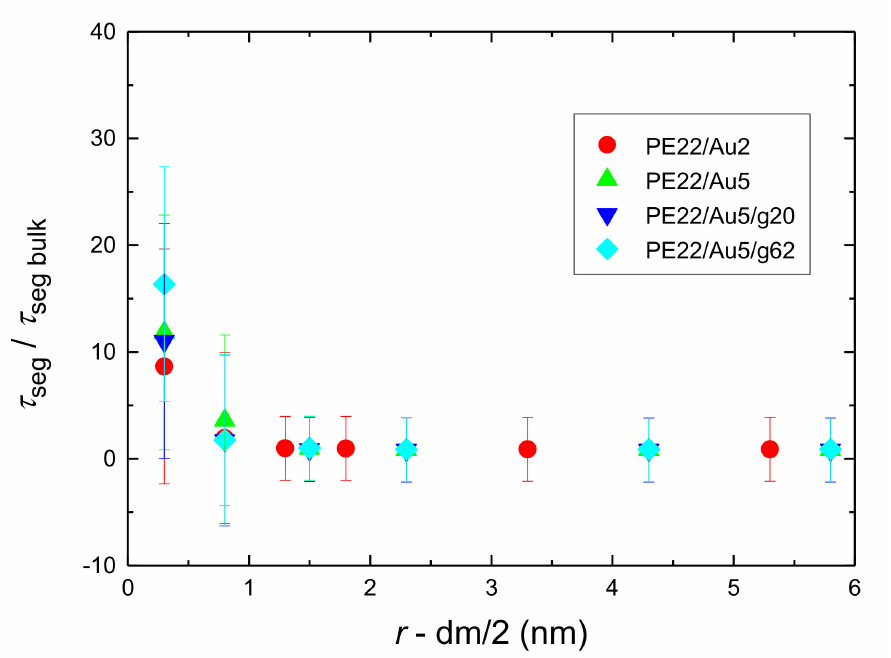
Figure A9. Segmental relaxation times of PE chains, scaled with the value of bulk chains, τ seg / τ seg bulk , as a function of distance from the center of the Au NP, r , minus the half diameter of the NP, for all systems with PE matrices consisting of 22 mers per chain.